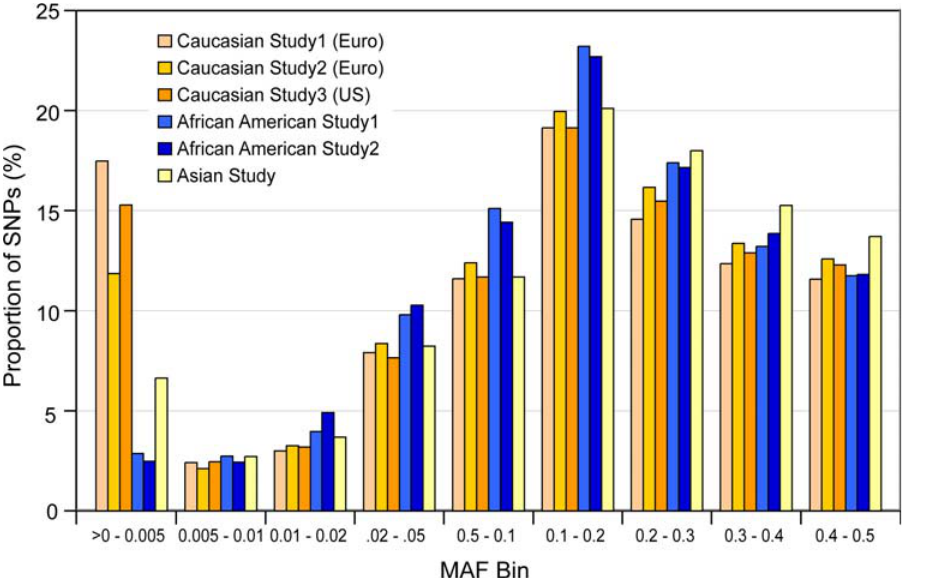
Figure 2. MAF distribution for IBCv1 assays across studies of Caucasians, African Americans and South Asians. Proportion of polymorphic variants (as a % of total) are described on the y-axis with the x-axis illustrating bins of the minor allele frequencies (MAF) for six different studies; Caucasian Study 1 (n=2094 European); Caucasian Study 2 (n=2150 European); Caucasian Study 3 (n=1054 European American); African American Study 1 (n=254); African American Study 2 (n=130) and South Asians (n=385). doi:10.1371/journal.pone.0003583.g002 (Figure 3). The average coverage for Group 1 loci is , 36.5 SNPs per locus in IBCv1. The Illumina Human1M and Affymetrix 6.0 platform, for comparison, have an average of , 28.0 and , 17.4 SNPs respectively across the equivalent IBC loci. The average number of SNPs observed for the Group 2 loci is , 16.3 SNPs which is comparable with the current GWAS products.